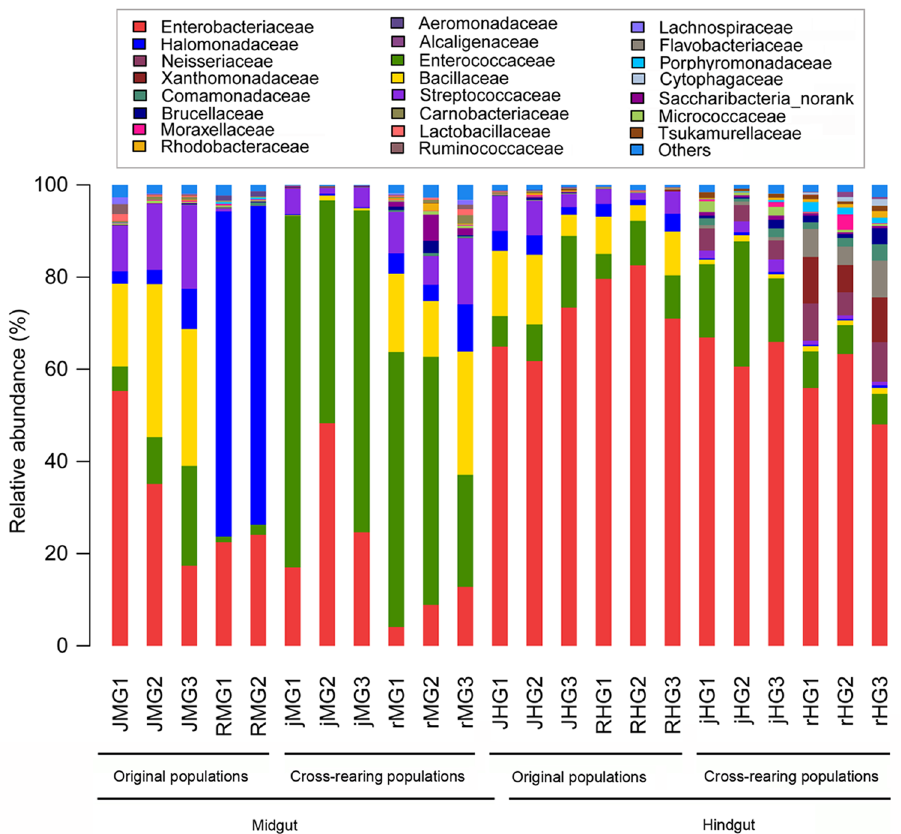
Figure 4. Compositions of gut microbiota at the family level of original and cross-rearing populations of C. suppressalis . The Y-axis represents the proportion of each taxon. JMG1–JMG3 midguts of water-oat population feeding on water-oat fruit pulps, RMG1–RMG2 midguts of rice population feeding on rice seedlings, jMG1– jMG3 midguts of water-oat population feeding on rice seedlings, rMG1–rMG3 midguts of rice population feeding on water-oat fruit pulps, JHG1–JHG3 hindguts of water-oat population feeding on water-oat fruit pulps, RHG1–RHG3 hindguts of rice population feeding on rice seedlings, jHG1–jHG3 hindguts of water-oat population feeding on rice seedlings, rHG1–rHG3 hindguts of rice population feeding on water-oat fruit pulps; Original populations: C. suppressalis collected from water-oat field and reared on water-oat fruit pulps; or C. suppressalis collected from rice field and reared on rice seedlings. Cross-rearing populations: C. suppressalis collected from water-oat field but reared on rice seedlings; or C. suppressalis collected from rice field but reared on water-oat fruit pulps. Abbreviations for each sample are explained in Tables 1 and